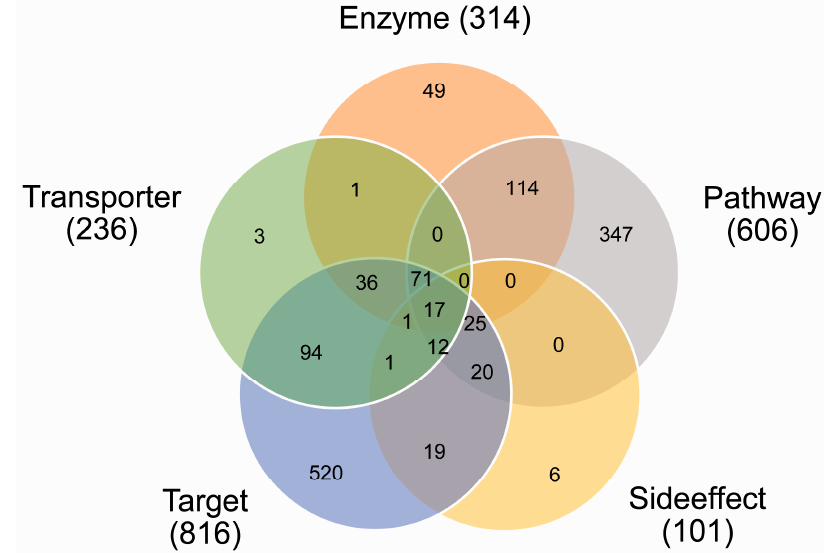
Figure 1. The Venn diagram of drug combinations for five types of features, where the numbers show how many drug pairs (there were a total of 946 drug pairs) can be covered by different features or combinations of these feature types.